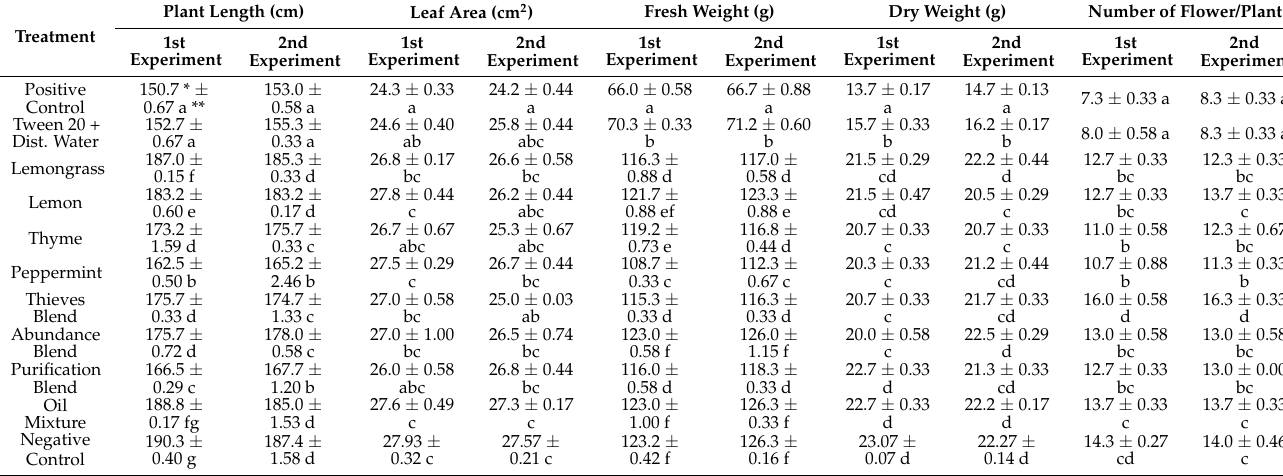
Table 3. Effect of treatment with essential oils (2.5 mL/L) on the morphology of the cucumber plants under greenhouse conditions.